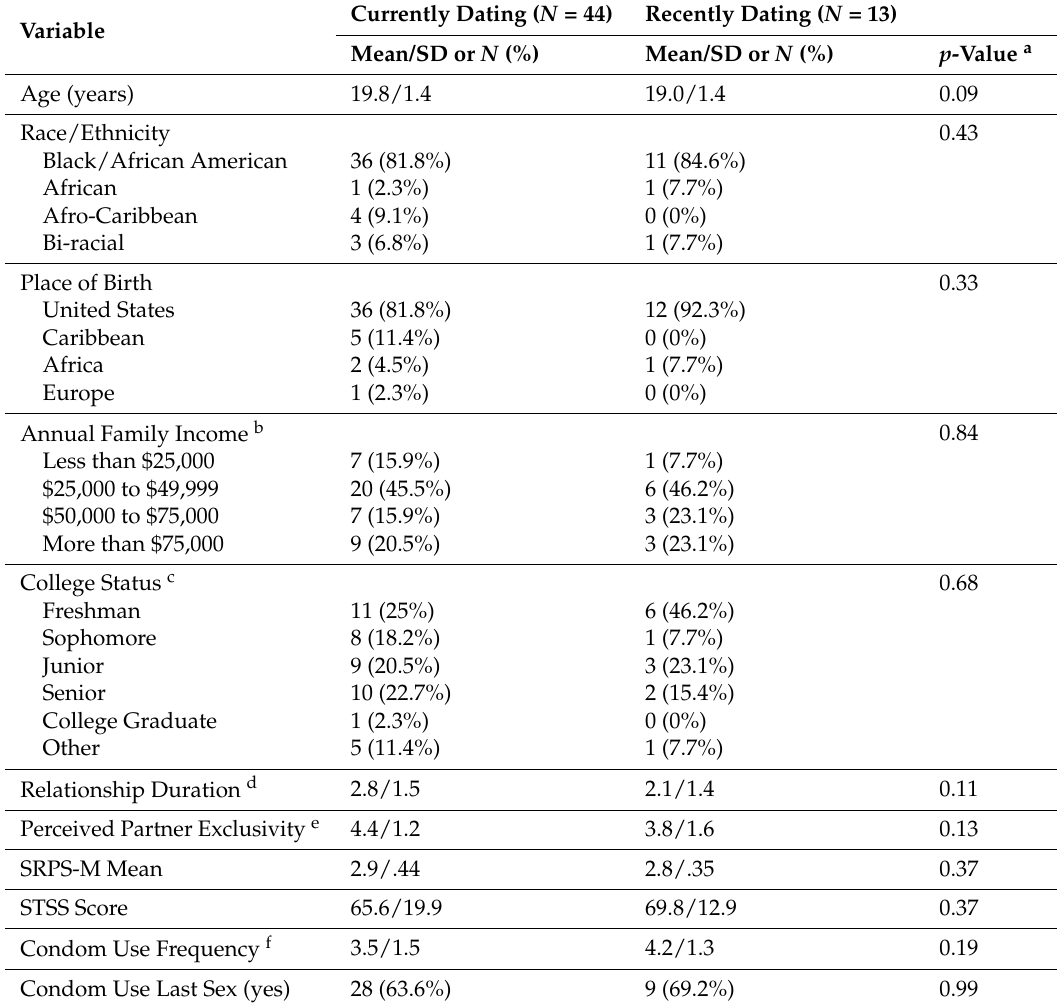
Table 2. Comparisons between Participants Currently in a Dating Relationship and Participants Reporting on Their Most Recent Dating Relationship ( N =